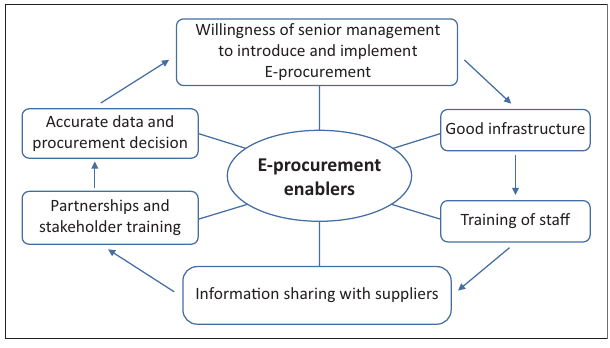
FIGURE 1: The e-procurement